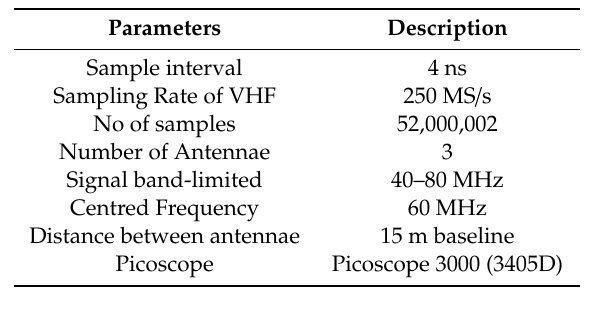
Table 1. The parameters for the interferometer and the lightning flash.